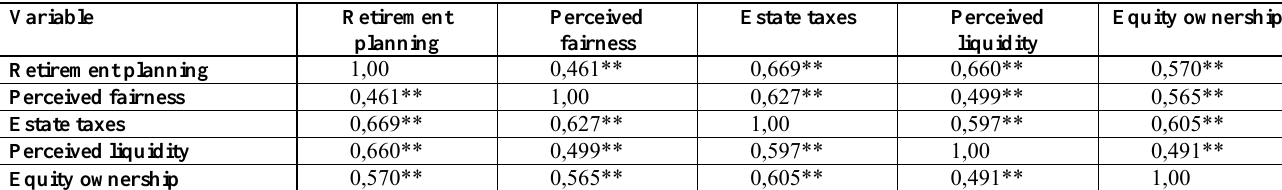
Table 2: Results of the Pearson correlation coefficients ( r ) between constructs